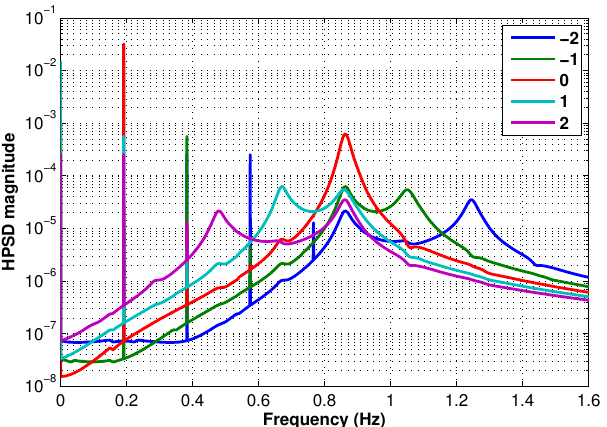
Figure 2. Harmonic power spectrum of the ζ 2 output of the wind turbine analytical model. The peak of the n = 0 curve is caused by the blade in-plane mode, while spikes are due to the rotational fre- quency and its